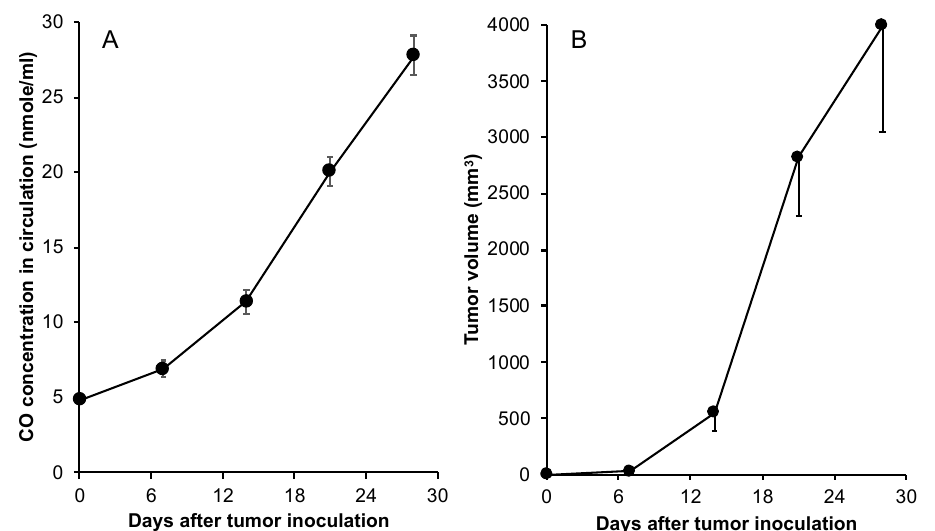
Figure 3. CO production in the mouse sarcoma S180 tumor model. In mouse sarcoma S180 tumor model, after tumor inoculation, mice were killed, and blood was collected. The CO concentrations in the blood were then measured by gas chromatography according to the protocol described in the text ( A ). Meanwhile, the sizes of tumors were measured and tumor volumes were calculated ( B ). Data are mean ± SEM, n = 4–6.